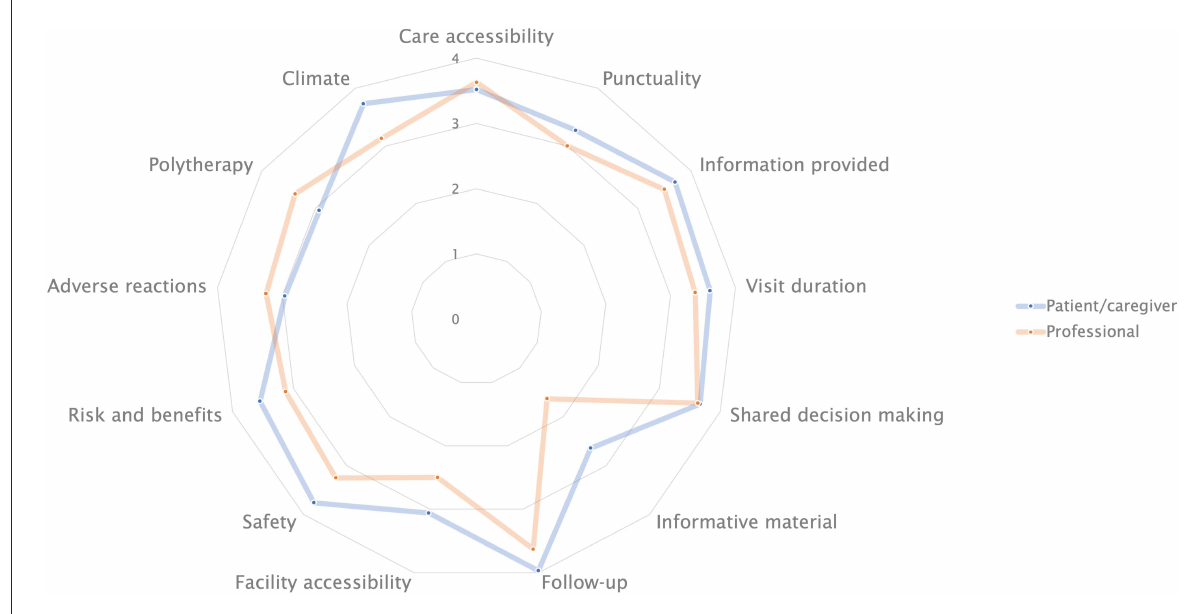
FIGURE1 Radar plot showing mean scores for item topic, as assigned by professionals and